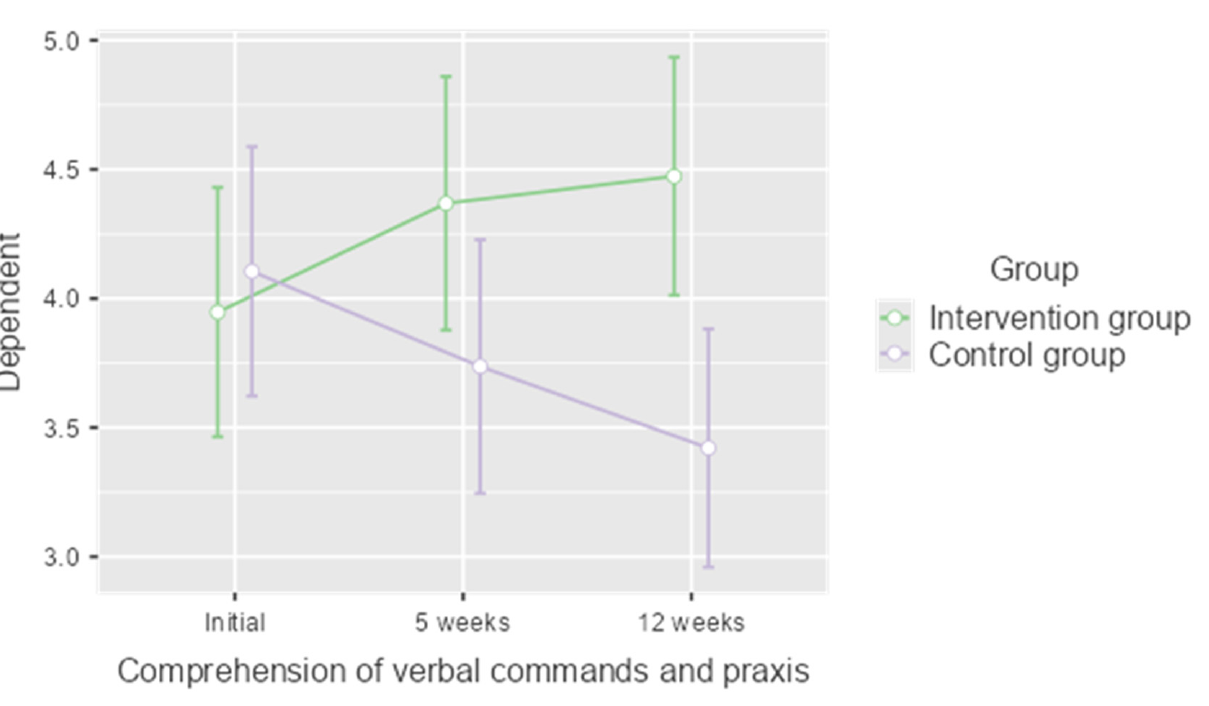
Table 3. Cognitive level (Lobo’s Cognitive Mini Test) of the patients after the application of the treatments. Intervention Group Control Group Outcome Measure Mean SD Media